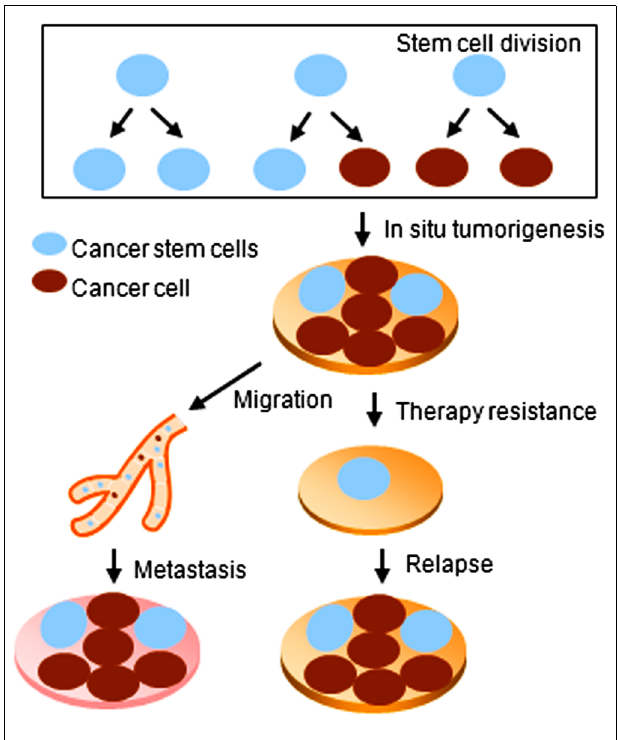
FIGURE 1 | Cancer stem cells play key roles during tumorigenesis, relapse, and metastasis of